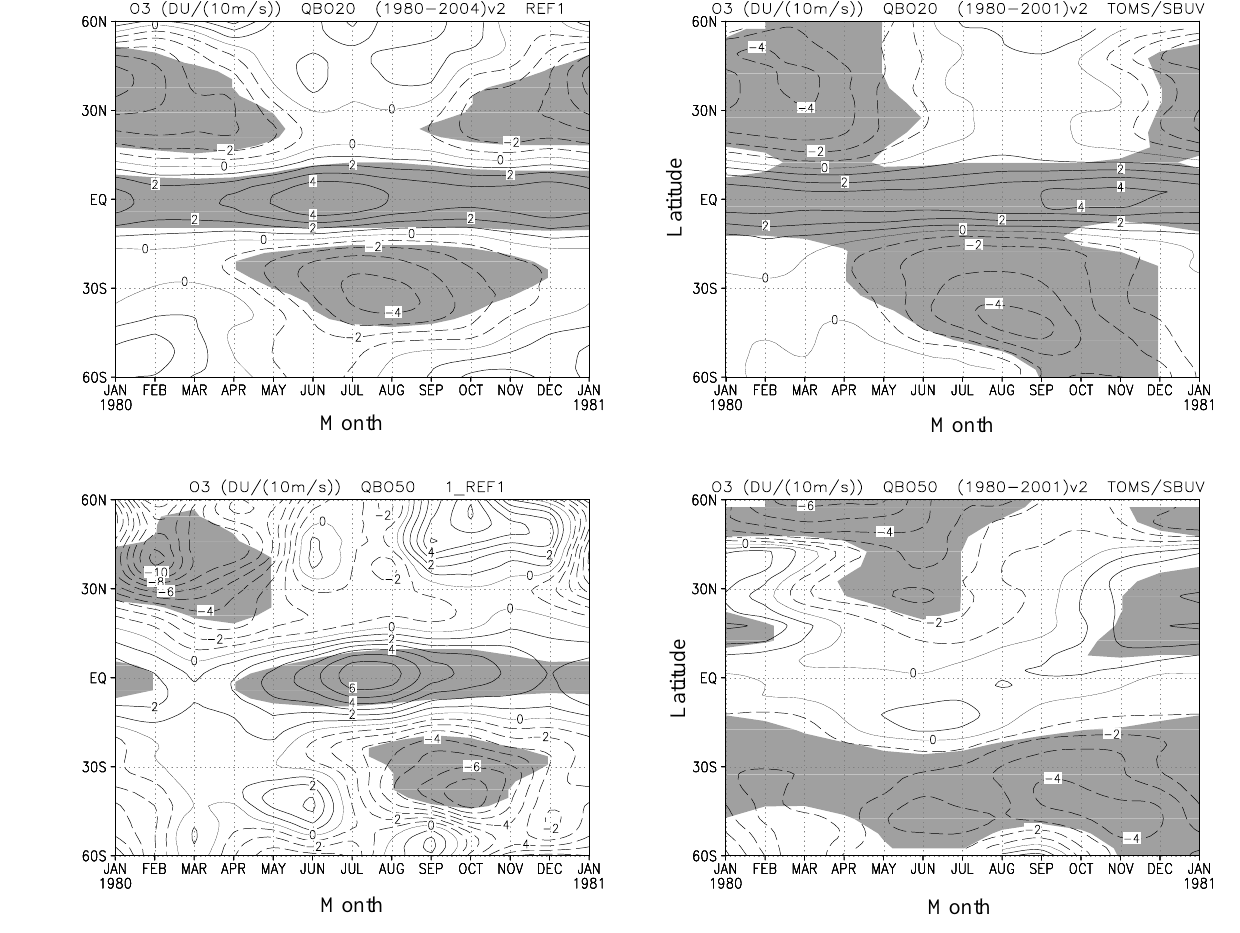
Fig. 15. Month-latitude cross sections of the QBO20 (upper) and QBO50 (lower) total ozone in DU per 10m/s of the QBO winds at 20 and 50hPa between 60 ◦ S and 60 ◦ N for the simulation (left) and observation (TOMS/SBUV) (right). Contour interval is 1DU/year, and shading denotes the 95% confidence level (t-test).